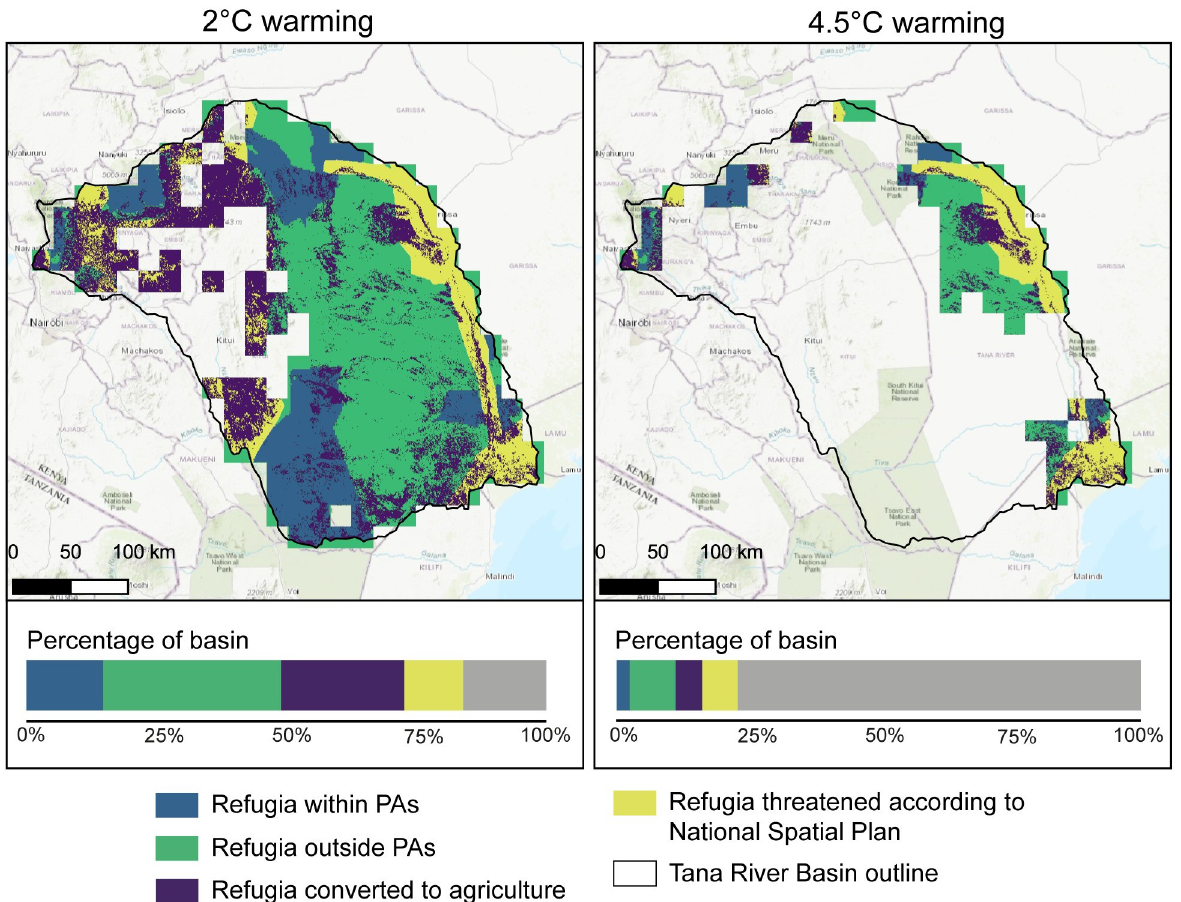
Fig 4. Locations of refugia with 2˚C and 4.5˚C warming. Refugia are projected only if 11 or more GCMs agree on their presence for at least one of the five taxa considered in this study. Bars show the percentage of the basin within each of the categories. Grey indicates the percentage of the basin which is not projected to contain refugia. Protected Areas data was obtained from the World Database of Protected Areas: